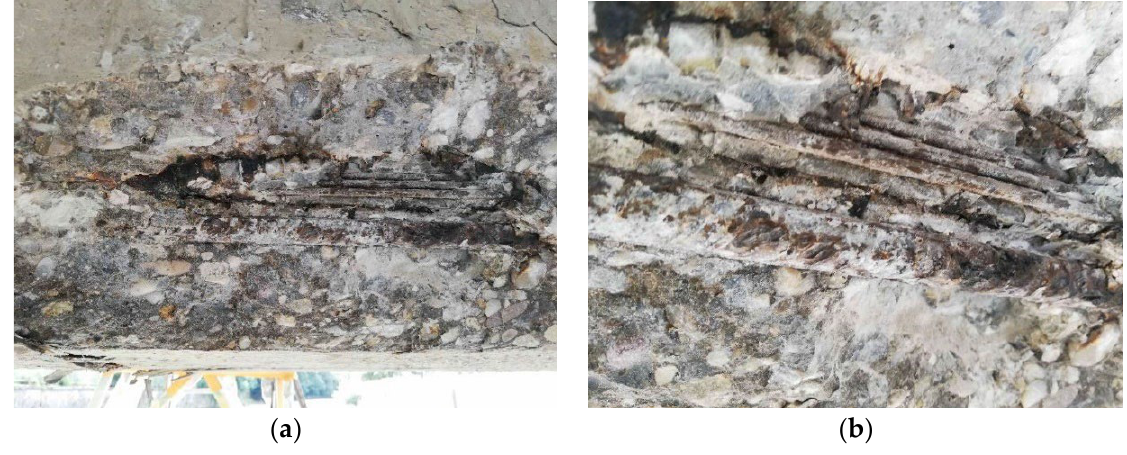
Figure 5. Prestressing wires after exposure in the midspan area—view ( a ); detail ( b ). Anchoring of the prestressing tendons was provided by the so-called Horel anchoring wedge system, based on the Freyssinet principle. This system was commonly used in former Czechoslovakia at the time of the construction of the assessed bridge [1]. During the diagnostic survey, the anchorage areas on both sides of the bridge were exposed. The anchorages on the side of the bridge which was closer to the city center were in worse conditions than the anchorages by the railway station. The anchorages can be seen in Figures 7 and